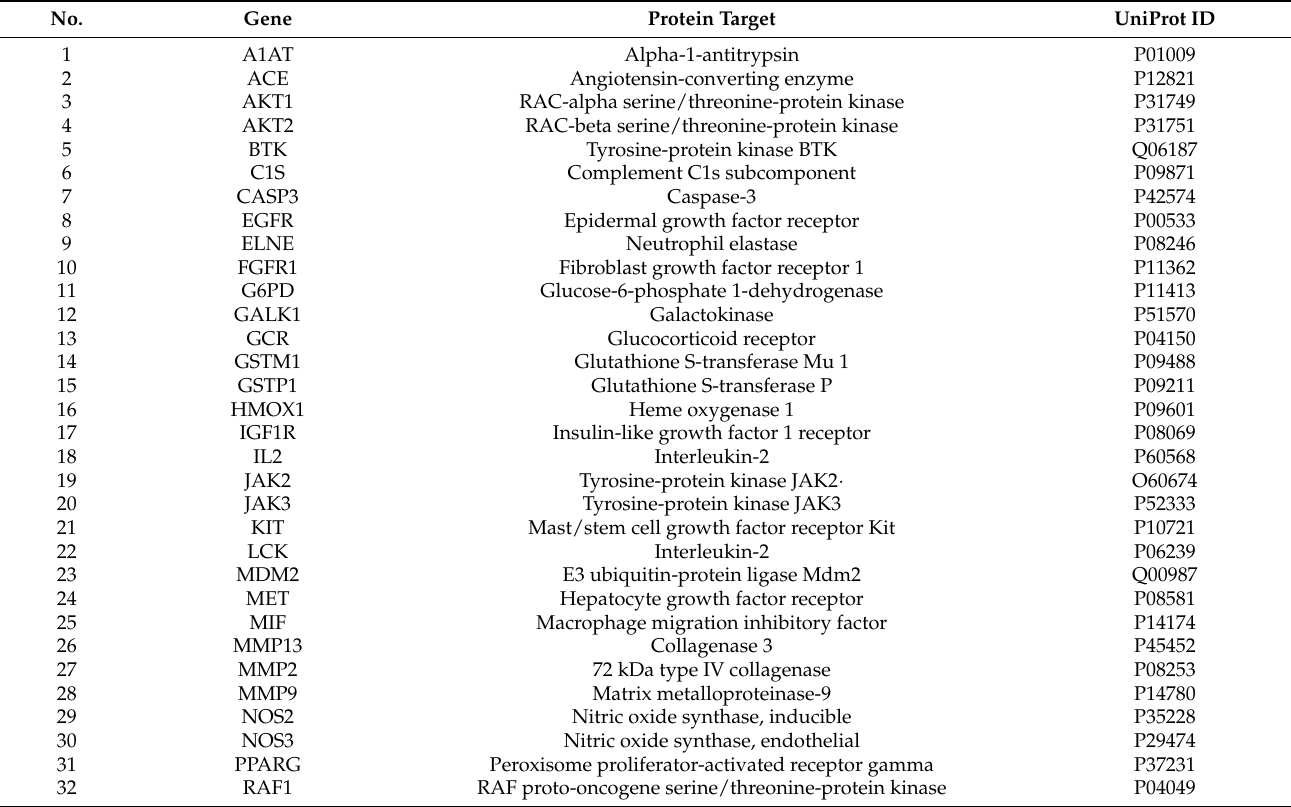
Table 1. List of predicted genes of tripeptides intervene in acute